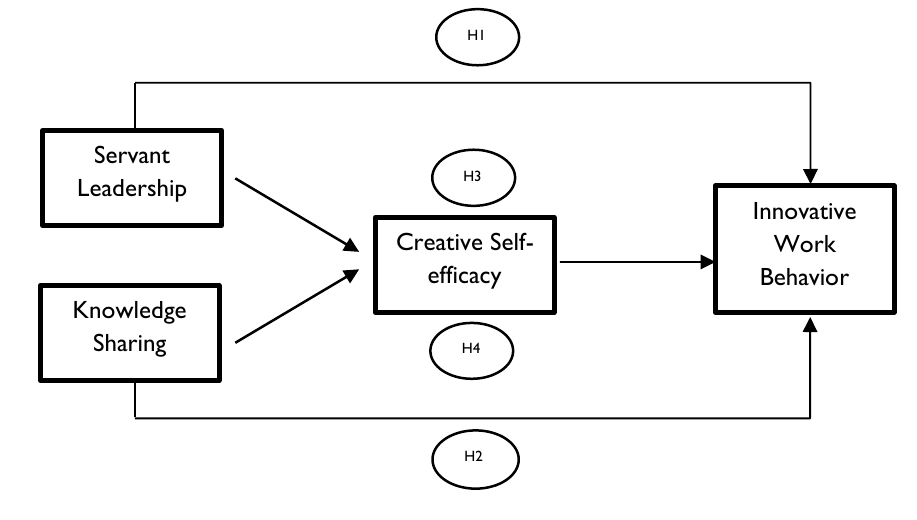
Figure 1. Conceptual framework